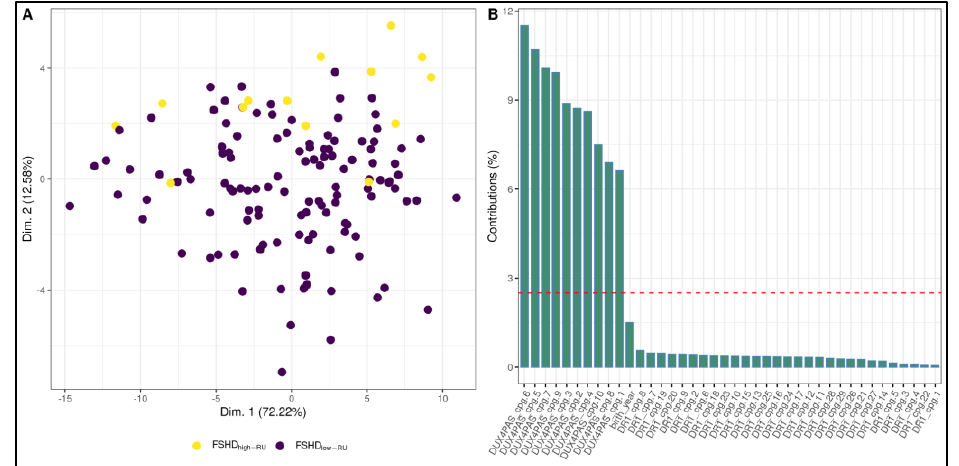
Figure 7. Random forest model for the discrimination between FSHD low-RU and FSHD high-RU subjects. ( A ) A PCA plot highlighting slight separation between FSHD low-RU and FSHD high-RU groups. In particular, the largest separation appears on Dimension 2. ( B ) Suggestively, variable contributions to Dimension 2 are mostly from DUX4 -PAS CpG sites. The most important variable for the selected Random Forest (fitted on the PCA dimensions) is indeed Dimension 2.